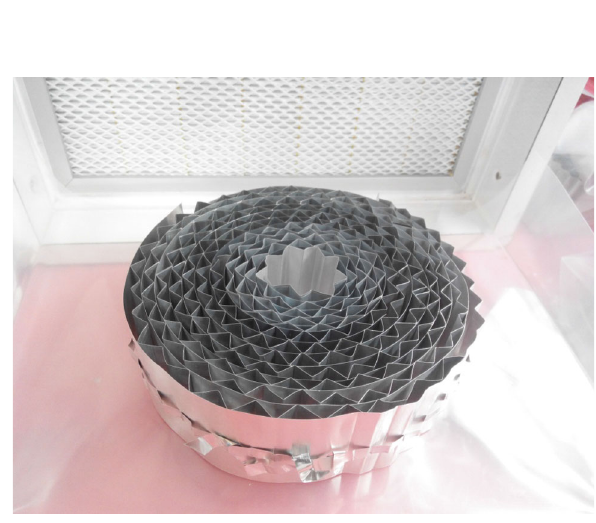
Fig. 2 A photo of the